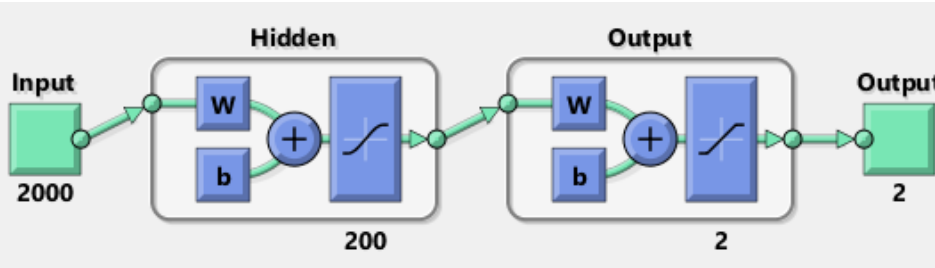
Figure 10. General ANN architecture used in this